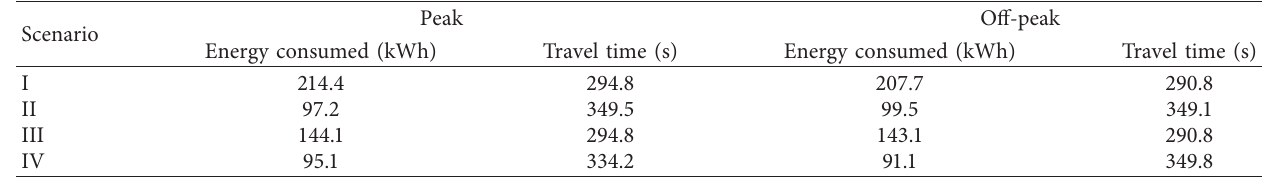
Figure 3: Optimal speed and energy profiles over space and time for various scenarios (peak). (a) Optimal speed profiles. (b) Speed/time plots. (c) Optimal energy profiles. Table 2: Optimized results with various scenarios during peak and off-peak